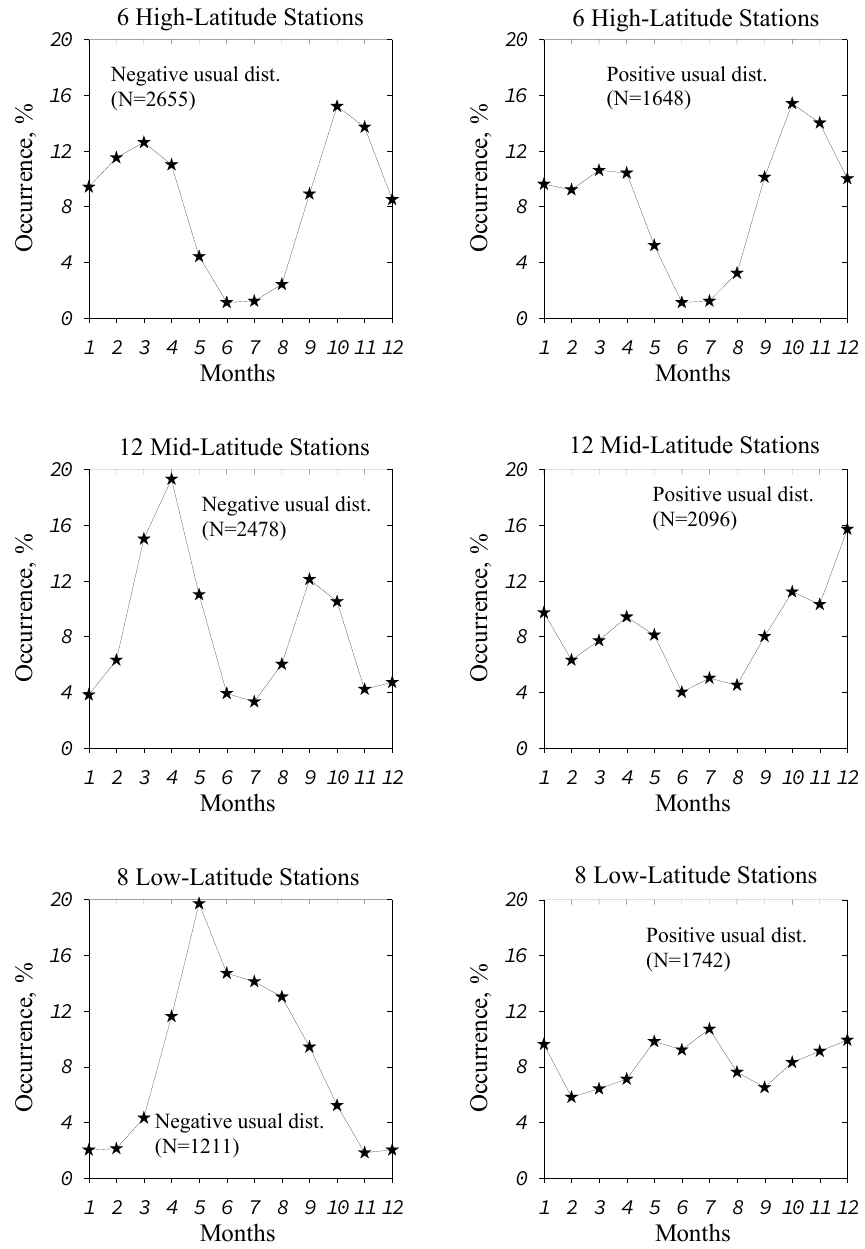
Fig. 2. Seasonal variations of the occurrence for usual storm-induced negative (left panels) and positive (right panels) F2-layer disturbances Fig. 2. at high, middle, and lower latitude stations in the daytime (09:00–15:00)LT sector. All solar activity levels are put together, total number of events is given in